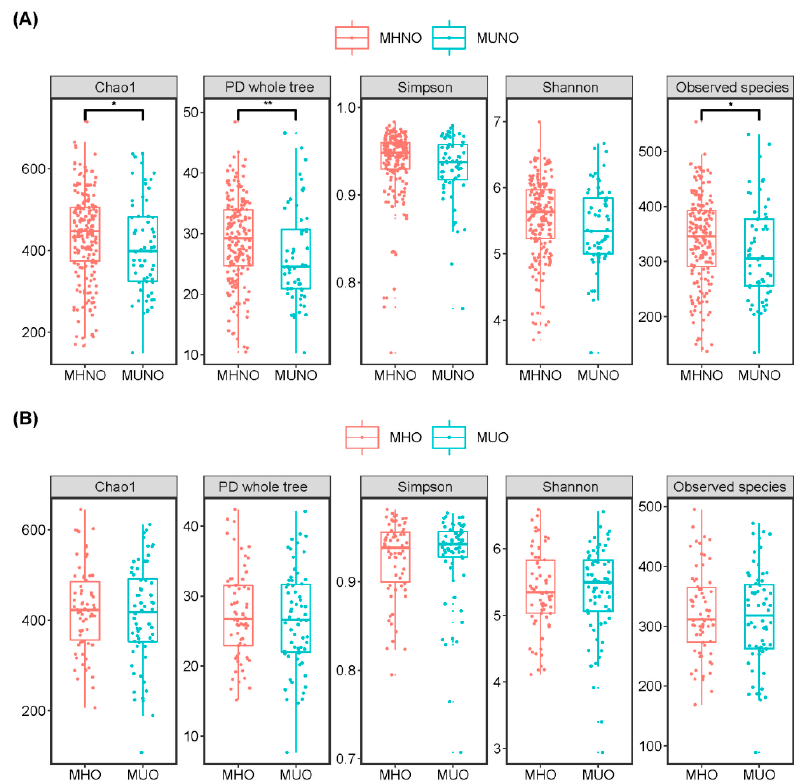
Figure 1. Alpha diversity comparisons between ( A ) MHNO and MUNO individuals, ( B ) MHO and MUO individuals. p -values were calculated using Mann-Whitney U tests for unpaired groups. Only the comparisons with false discovery rate-adjusted p values < 0.05 are presented. * p < 0.05, ** p < 0.01.